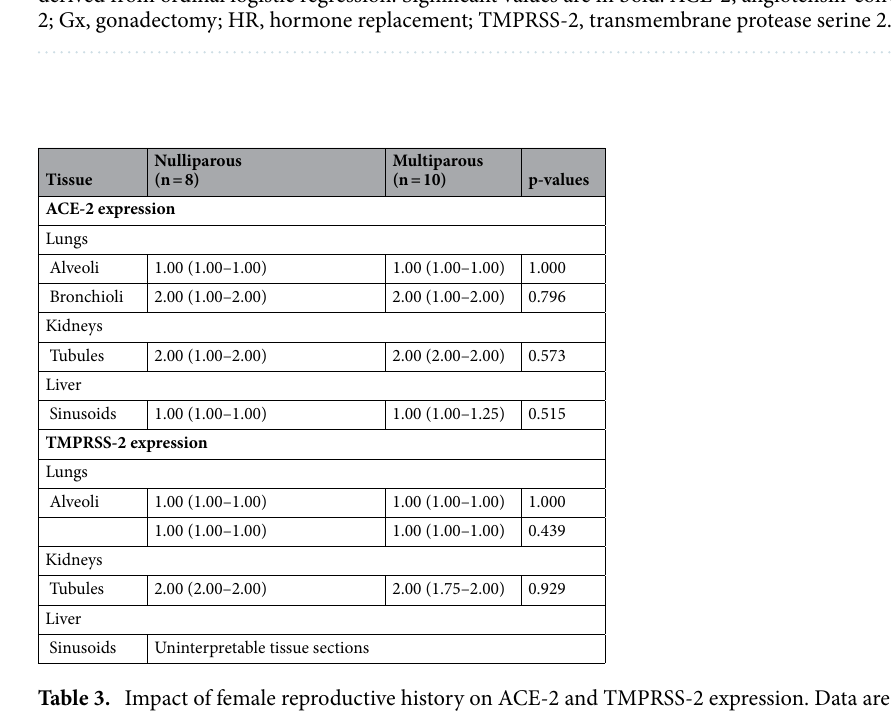
the respiratory tract in mice, independent of disease state. Previous data on ACE-2 and TMPRSS-2 expression in lung tissue have yielded conflicting results. Indeed, studies in both human and mouse tissue have reported